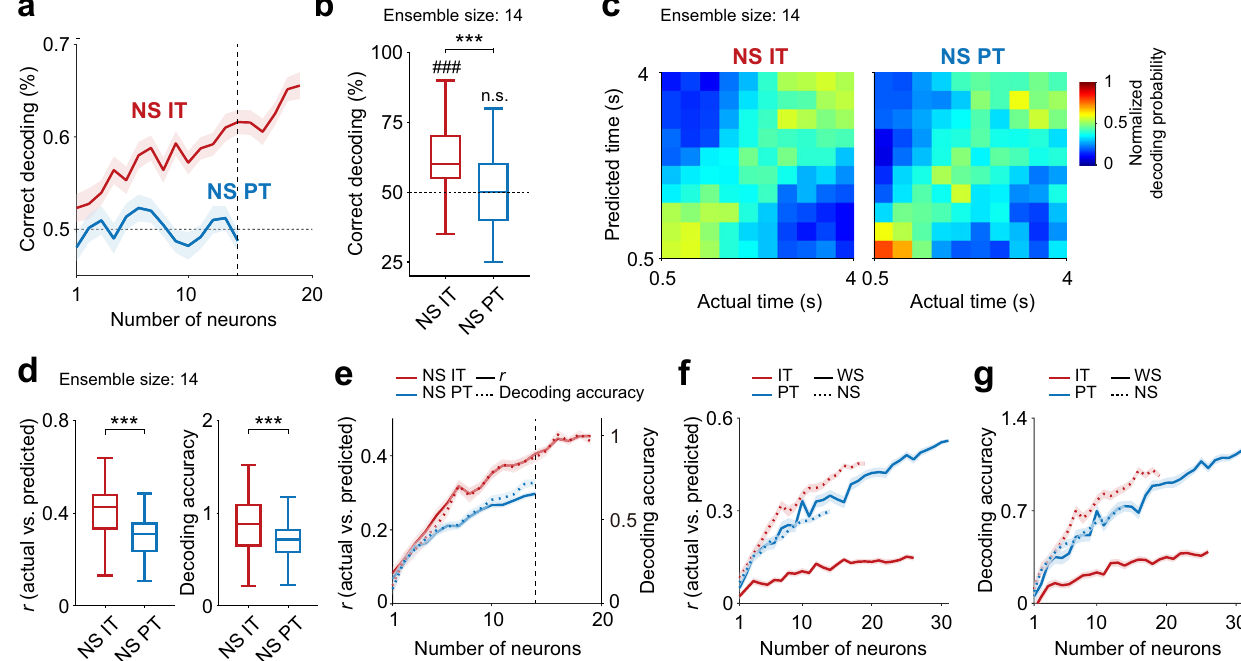
Fig. 9 Target and temporal information carried by optically-tagged NS neurons. a , b Neural decoding of target based on delay-period (4 s) neuronal ensemble activity ( n = 19 NS IT and 14 NS PT neurons). a Decoding performance as a function of ensemble size. b Decoding performance at ensemble size of 14 neurons (vertical dashed line in a ). ### p < 0.001 (above chance level, t -test); *** p < 0.001 (IT versus PT, t -test). The same format as in Fig. 3e, f. c – e Timing-related activity of NS IT and NS PT neurons ( n = 19 and 14, respectively). c Heat maps showing mean normalized decoding probabilities (actual versus predicted bins; ensemble size = 14 neurons). d Decoding performance (left, correlation between the actual and predicted bins; right, decoding accuracy) of NS IT and NS PT neuronal ensembles ( n = 14, vertical dashed line in e ). *** p < 0.001 ( t -test). e Decoding performance as a function of ensemble size. The same format as in Fig. 6a – c. f , g Comparison of temporal decoding across different types of neurons. f Correlation between the actual and predicted bins. g Decoding accuracy. Shading, SEM across 100 decoding iterations ( a , e – g ). Boxplots ( b and d ) show median, interquartile range, and maximum and minimum within 1.5 interquartile